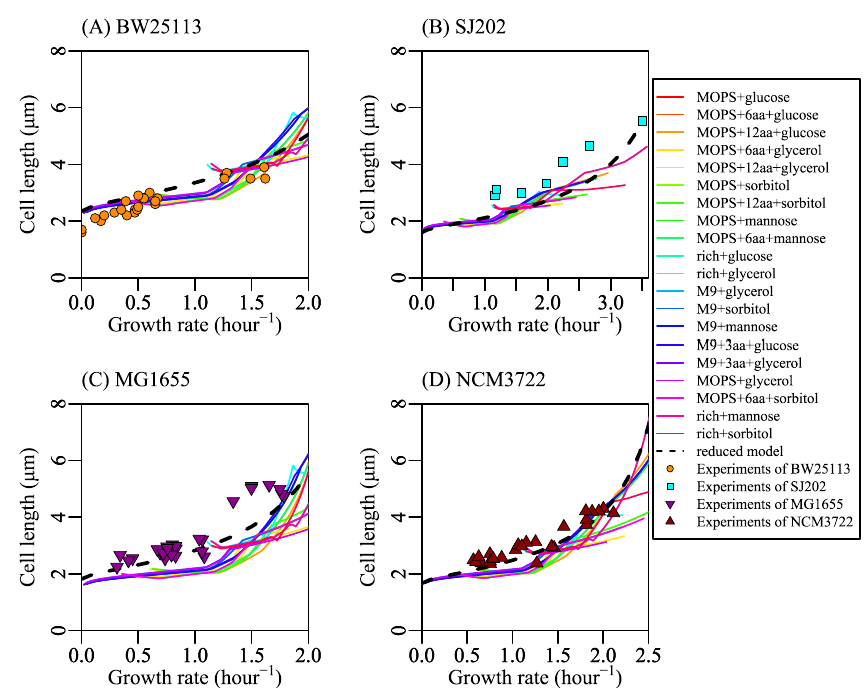
Figure A7. Relationship between growth rate and cell length with iJO1366 model. The simulations were done with iJO1366 model. The parameters used here are the same as those in Figure 2, except for β = 0.22. The results of SEFBA using iJO1366 model are similar to using iJR904 model.